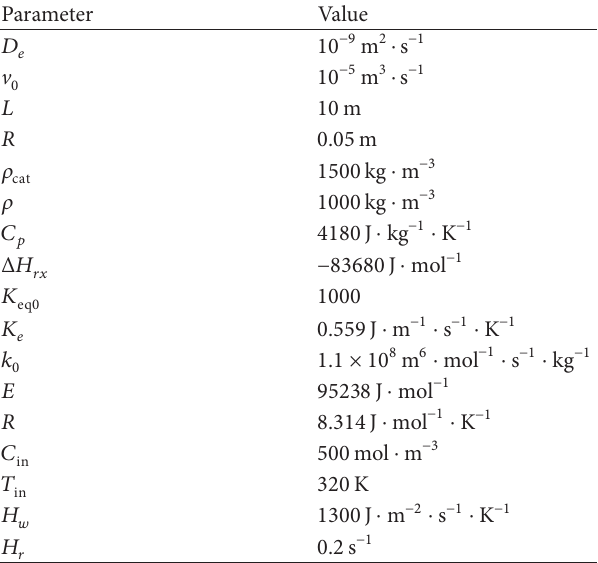
Table 1: Values of the reactor parameters with axial and radial diffusion, reaction, and